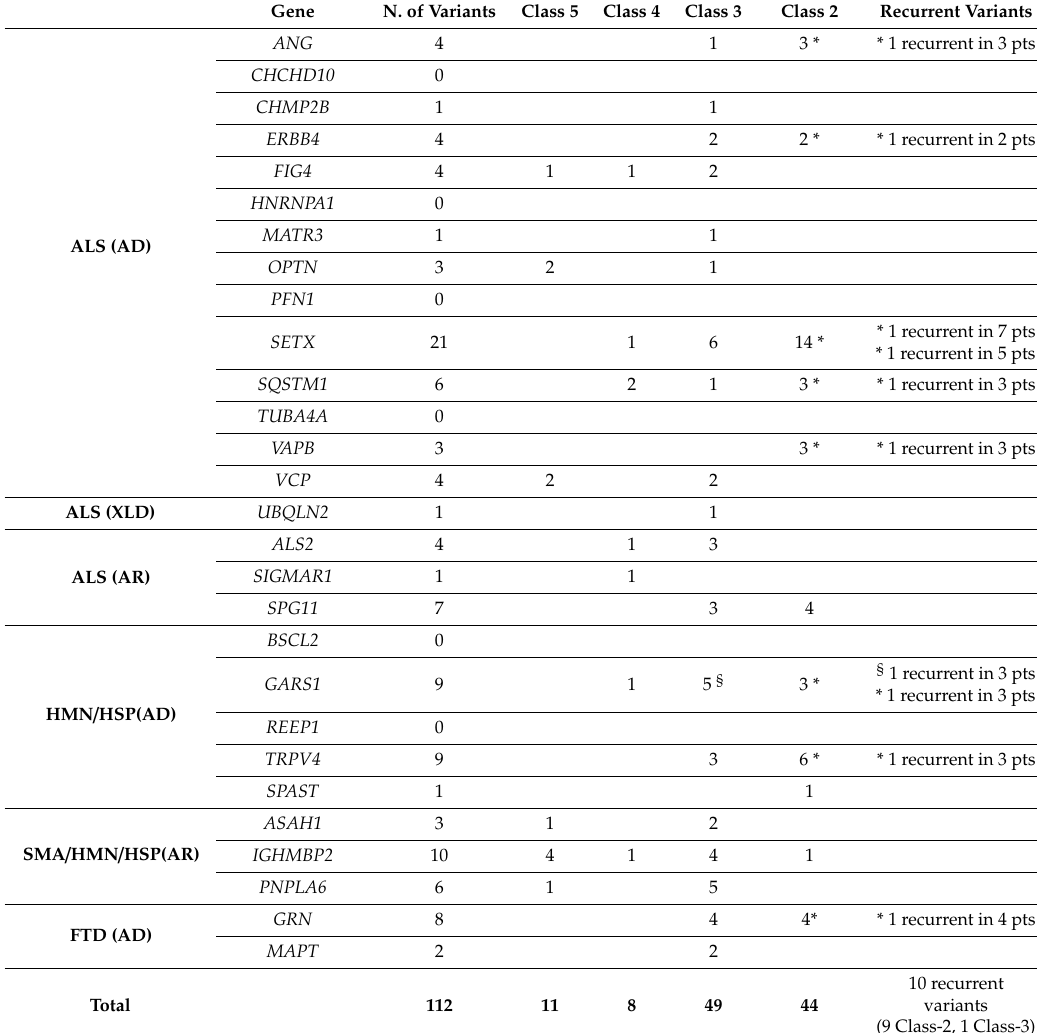
Table 2. Summary of identified gene variants and classes of